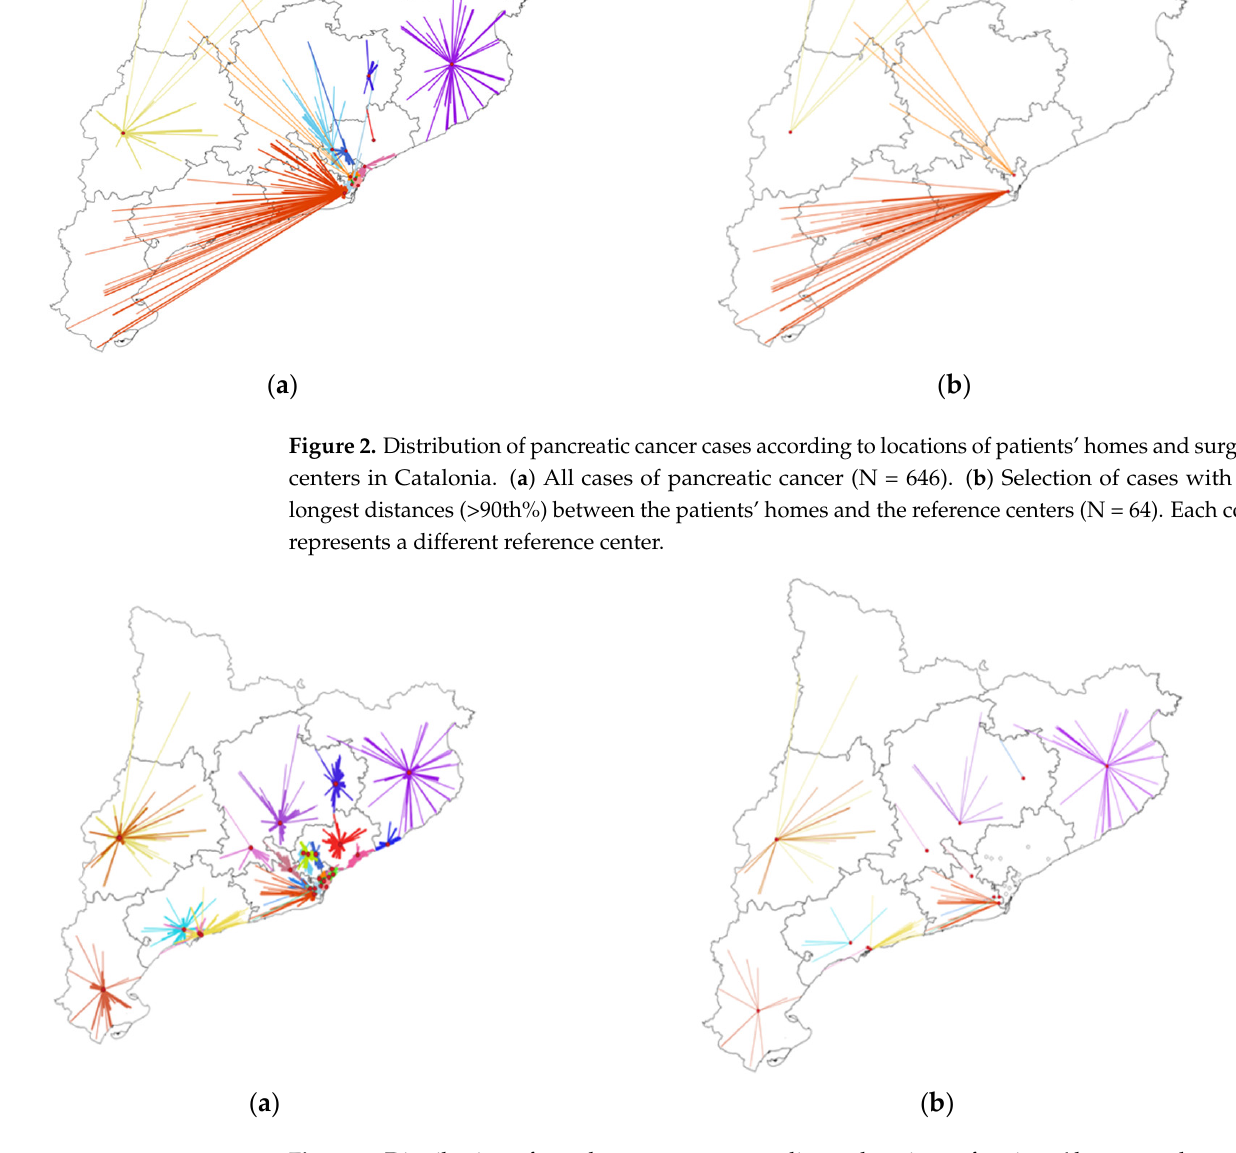
Figure 3. Distribution of rectal cancer cases according to locations of patients’ homes and surgical centers in Catalonia. ( a ) All cases of rectal cancer (N = 1455). ( b ) Selection of cases with the longest distances (>90th%) between the patients’ homes and the reference centers (N = 142). Each color represents a different reference center.